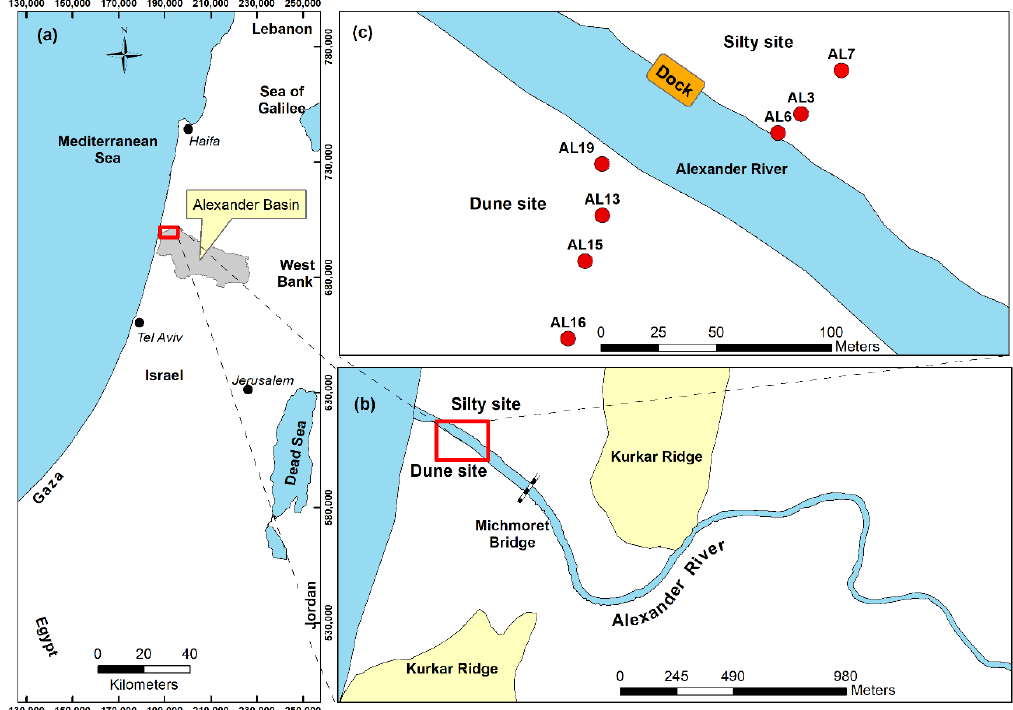
Figure 1. Maps of the study sites: ( a ) location map; ( b ) Alexander River area; ( c ) study site area. “Kurkar” is the local name for lithified calcareous sandstone.